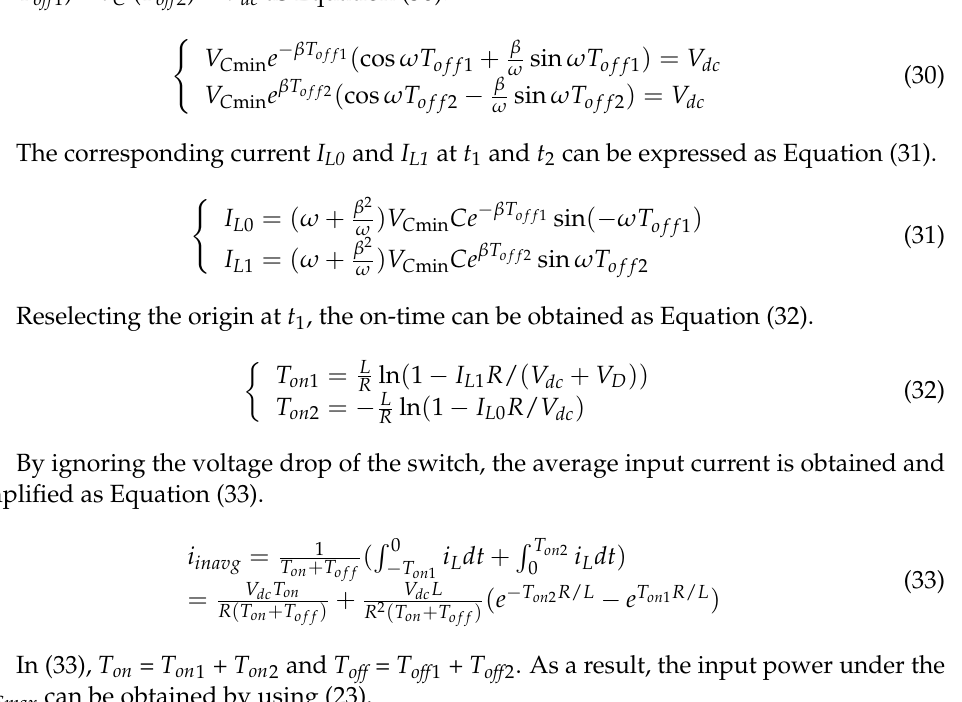
The corresponding current I L0 and I L1 at t 1 and t 2 can be expressed as Equation (31).